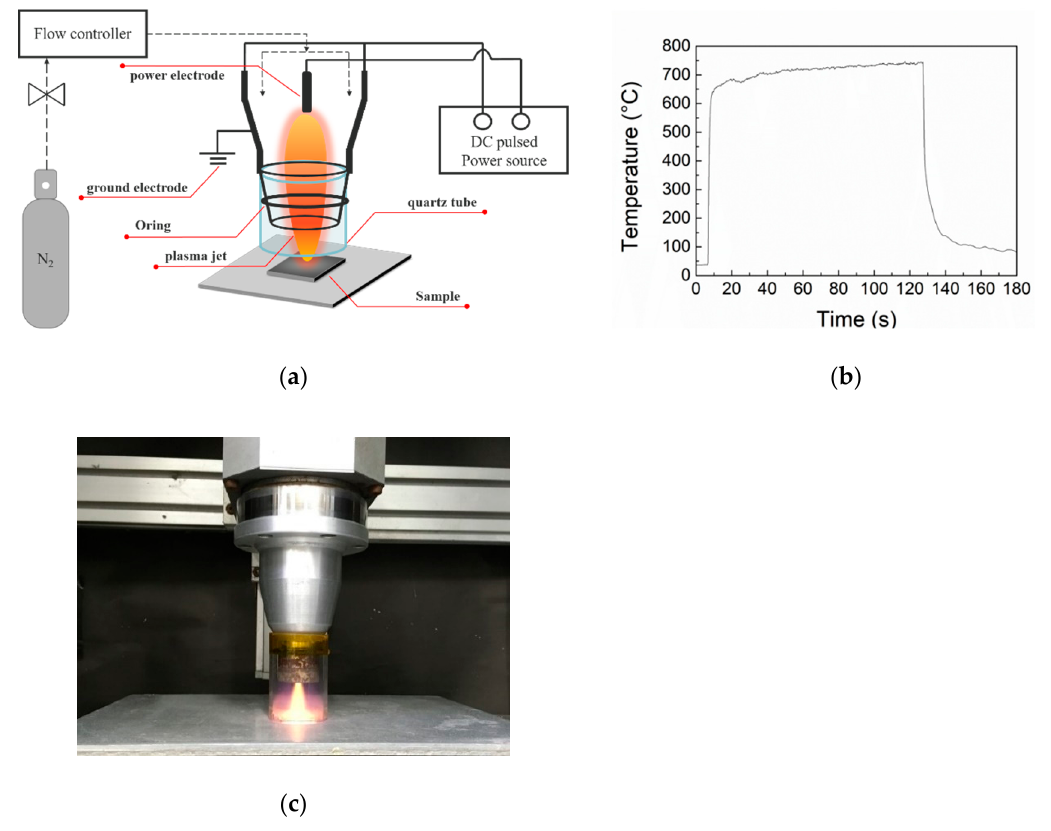
Figure 1. ( a ) Schematic of atmospheric-pressure plasma jet (APPJ) setup; ( b ) working temperature evolution of APPJ; ( c ) photograph of APPJ during processing.